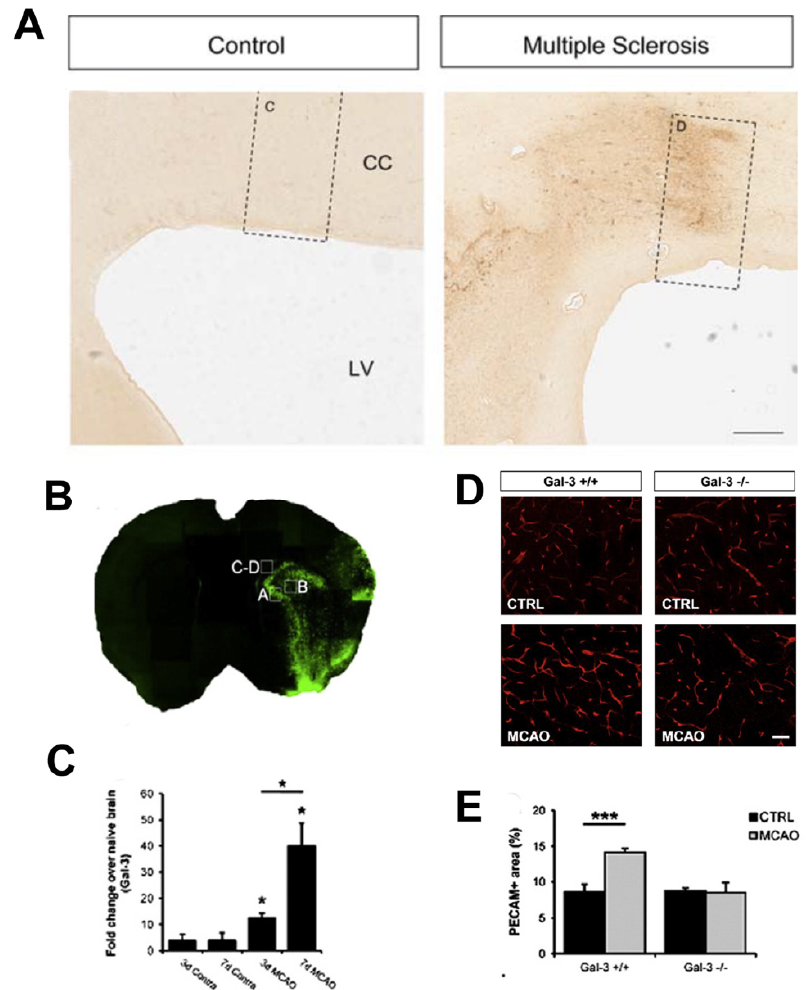
Figure 3. Galectin-3 is upregulated in multiple sclerosis and controls angiogenesis after stroke. ( A ) Gal-3 immunohistochemistry (brown) in human brain sections shows that compared to a healthy control, Gal-3 is increased near the lateral ventricle (LV) in an MS patient. (Adapted from [50]. ( B ) Gal-3 immunofluorescence (green) is increased in the striatum and cerebral cortex of a mouse middle cerebral artery occlusion (MCAO) stroke model. ( C ) Quantification of B showing significantly increased Gal-3 at days 3 and 7 post-stroke. ( D ) Platelet endothelial cell adhesion molecule (PECAM) blood vessel immunofluorescence (red) in the striatum of WT and Gal-3 − / − mice, with or without MCAO. ( E ) Quantification of D showing increased blood vessels after MCAO in controls but not in Gal-3 − / − mice. (( B – E ) Adapted from [10]), with permission. * p < 0.05, *** p <